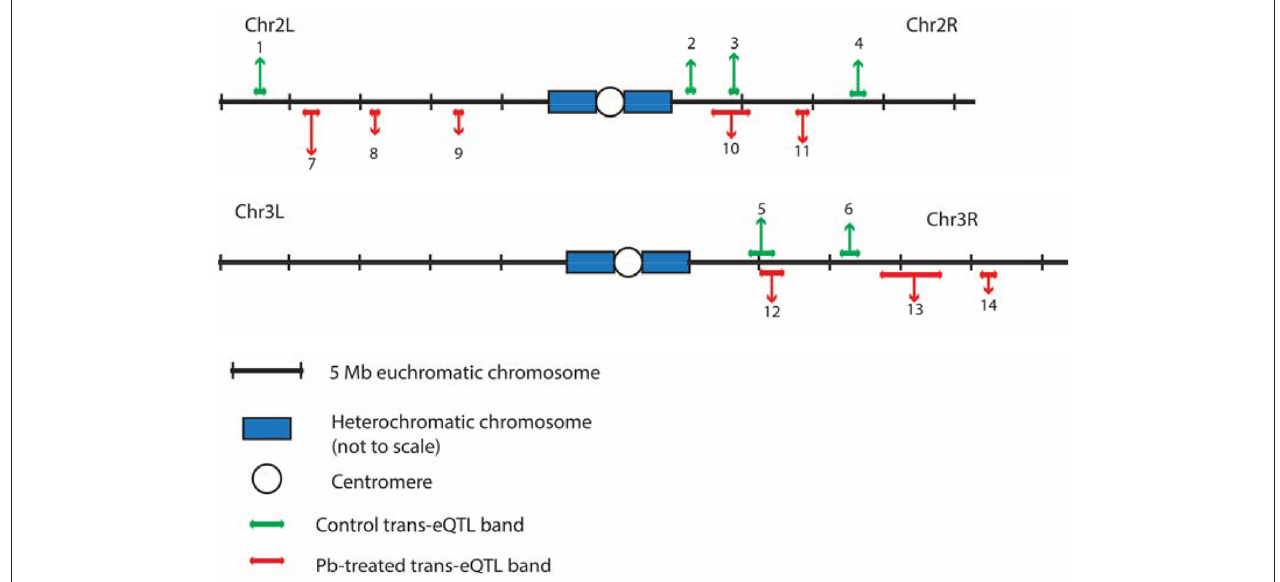
FIGURE 3 | The distributions of trans- eQTL hotspots among the Drosophila genome. Six for control (green, above the genomic axis) and 8 for lead-treated (red, under the genomic axis) trans- eQTL hotspots were detected in total. Chr 4 and heterochromatic chromosomes were excluded due to lack of genomic information from the DSPR group. Chr X has no trans- eQTL hotspots. All the trans- eQTL hotspots were numbered and the length of each arrow roughly represents the number of the associated genes. Details about these hotspots were shown in Table S1